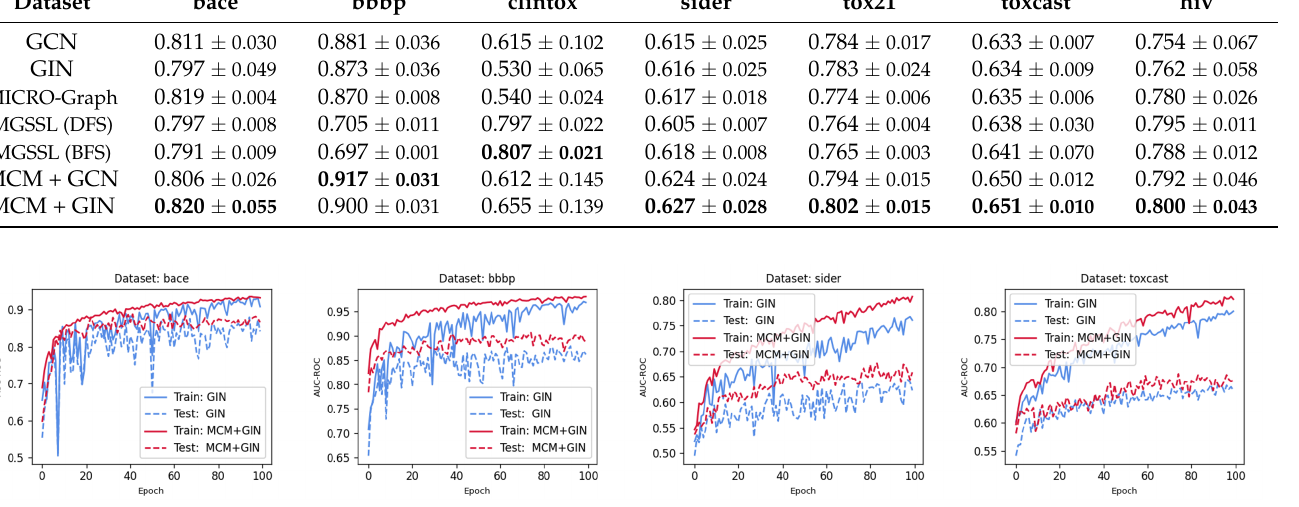
Figure 5. The training and testing curves on molecular benchmarks suggest MCM+GIN converge faster and more stably than